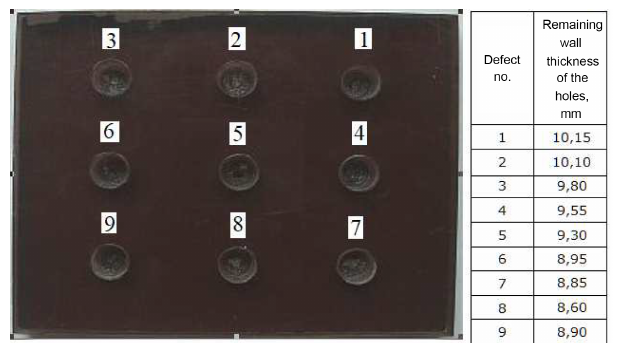
Figure 1. Slab of PMMA; view from the bottom side with nine visible holes imitating real flaws (mirrored